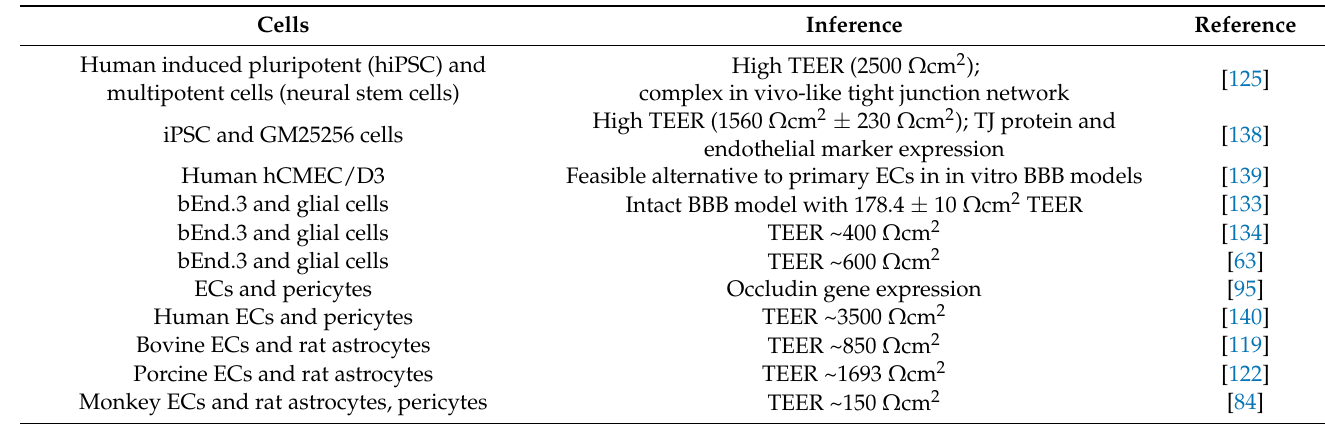
Table 2. Commonly used cells in in vitro co-culture BBB models. Cells Inference